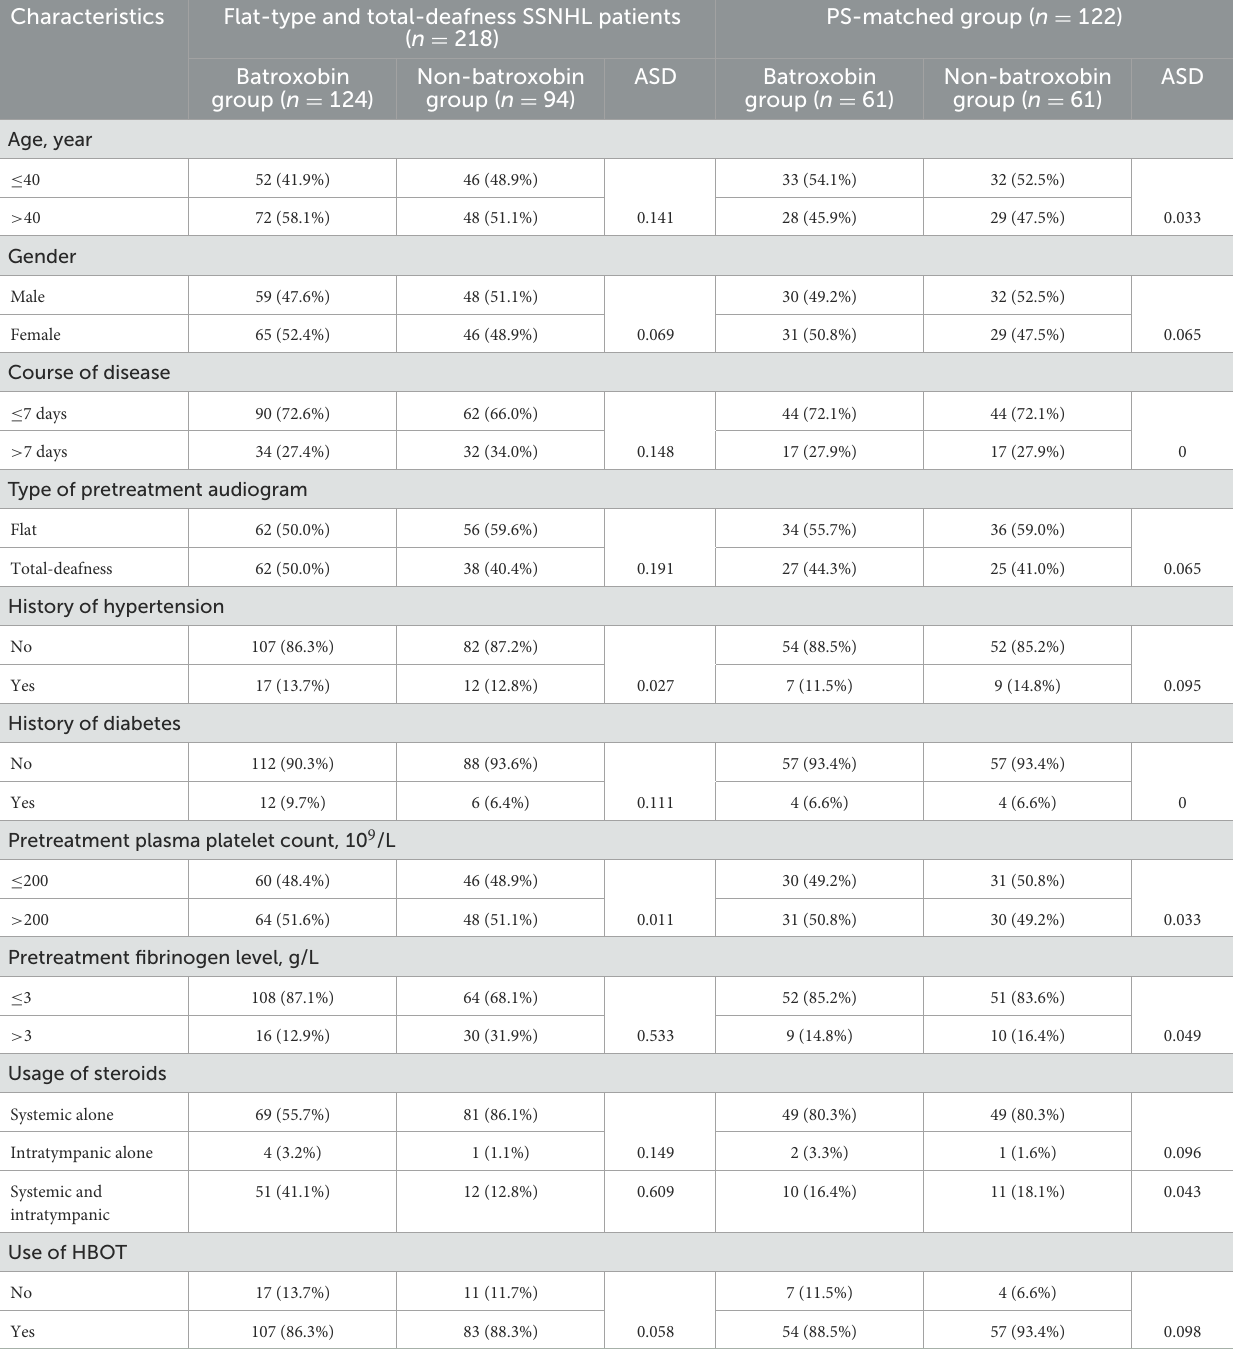
TABLE 3 Comparison of baseline characteristics between the batroxobin group and the non-batroxobin group in the sensitivity analysis.